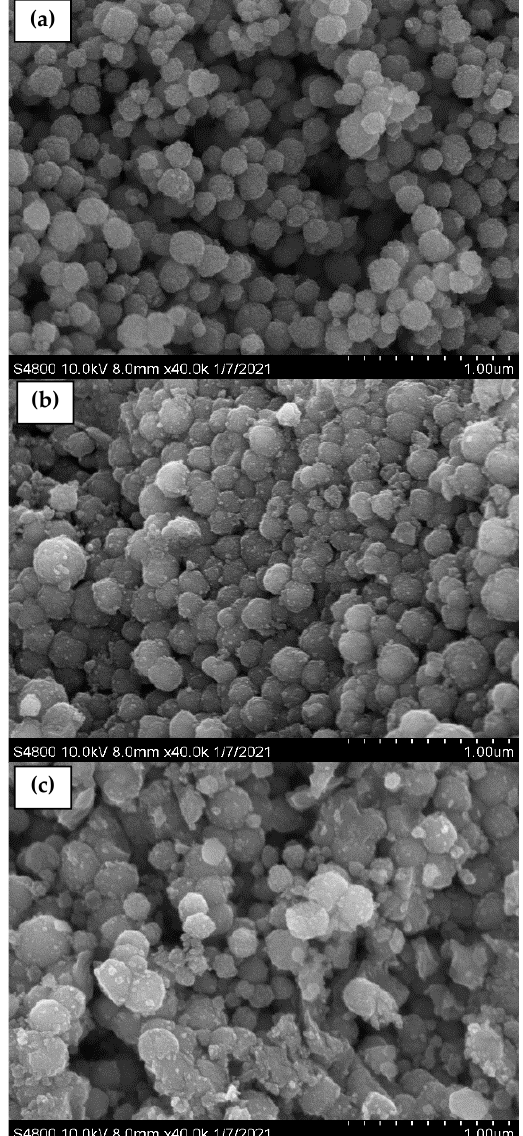
Figure 3. FE-SEM micrographs of as-synthesized ( a ) MNP, ( b ) MNP-F127-2, and ( c ) MNP-F127-3 Figure 3. FE-SEMmicrographsofas-synthesized( a )MNP,( b )MNP-F127-2,and( c